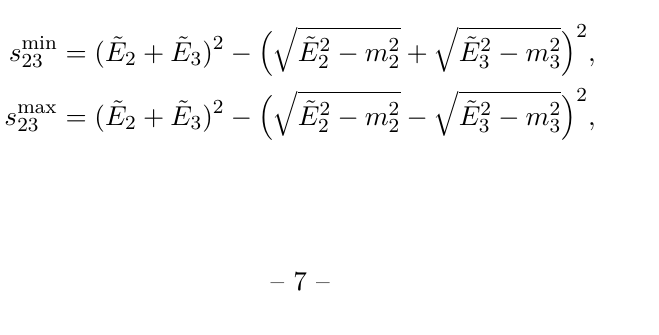
Figure 2 . Typical 3-body decay diagrams for S 3+ /S 2+ S 2+ /S + /φ 0 → W − ( ∗ ) + S 3+ /S 2+ 2 2 h ( ∗ ) + S 2+ /S + (d). Here u i = ( u, c ) , d i = ( d, s ) , ‘ = ( e, µ ) , and q = ( d, u, s, c, b ) 1 1